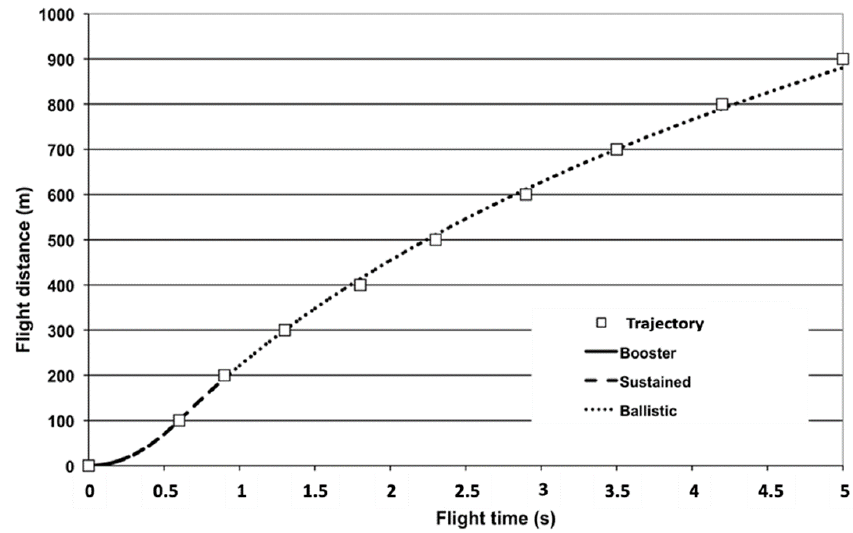
Figure 26. Comparison between the modelled trajectory and the available trajectory data from [4].